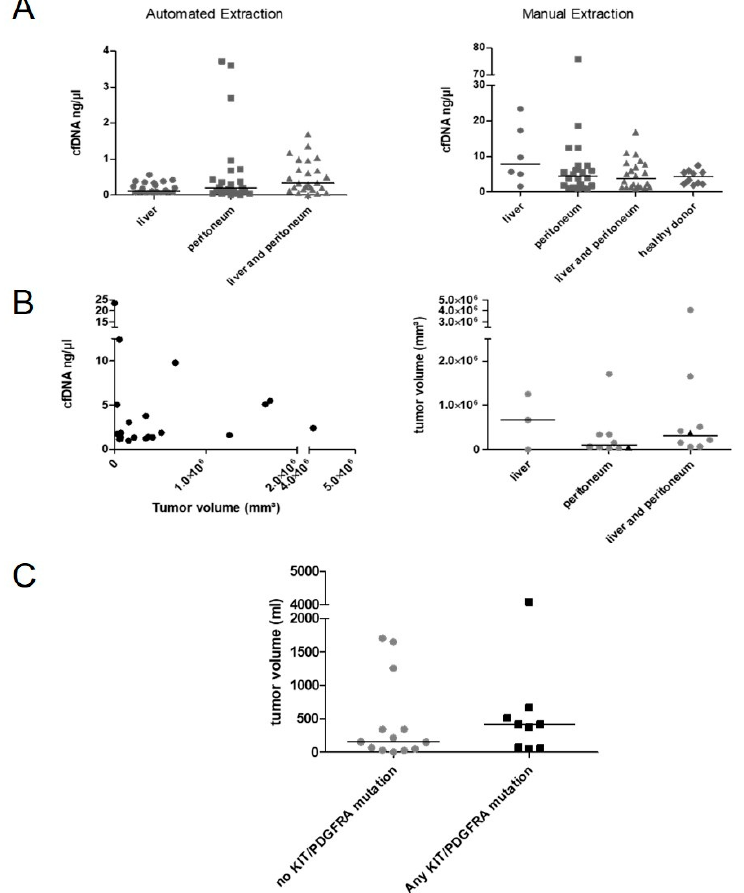
Figure 3. Impact of tumor localization and tumor volume on cfDNA concentration and detection of KIT/PDGFRA mutations. ( A ) Correlation of cfDNA concentration with location of metastasis divided by isolation methods. ( B ) Tumor volume did not correlate with cfDNA amounts (isolated manually). Tumor volume and localization of disease did not correlate. Triangle: primary mutation found. ( C ) Tumor volume was higher in patients with any detectable KIT mutations (not significant). Horizontal line displays median.